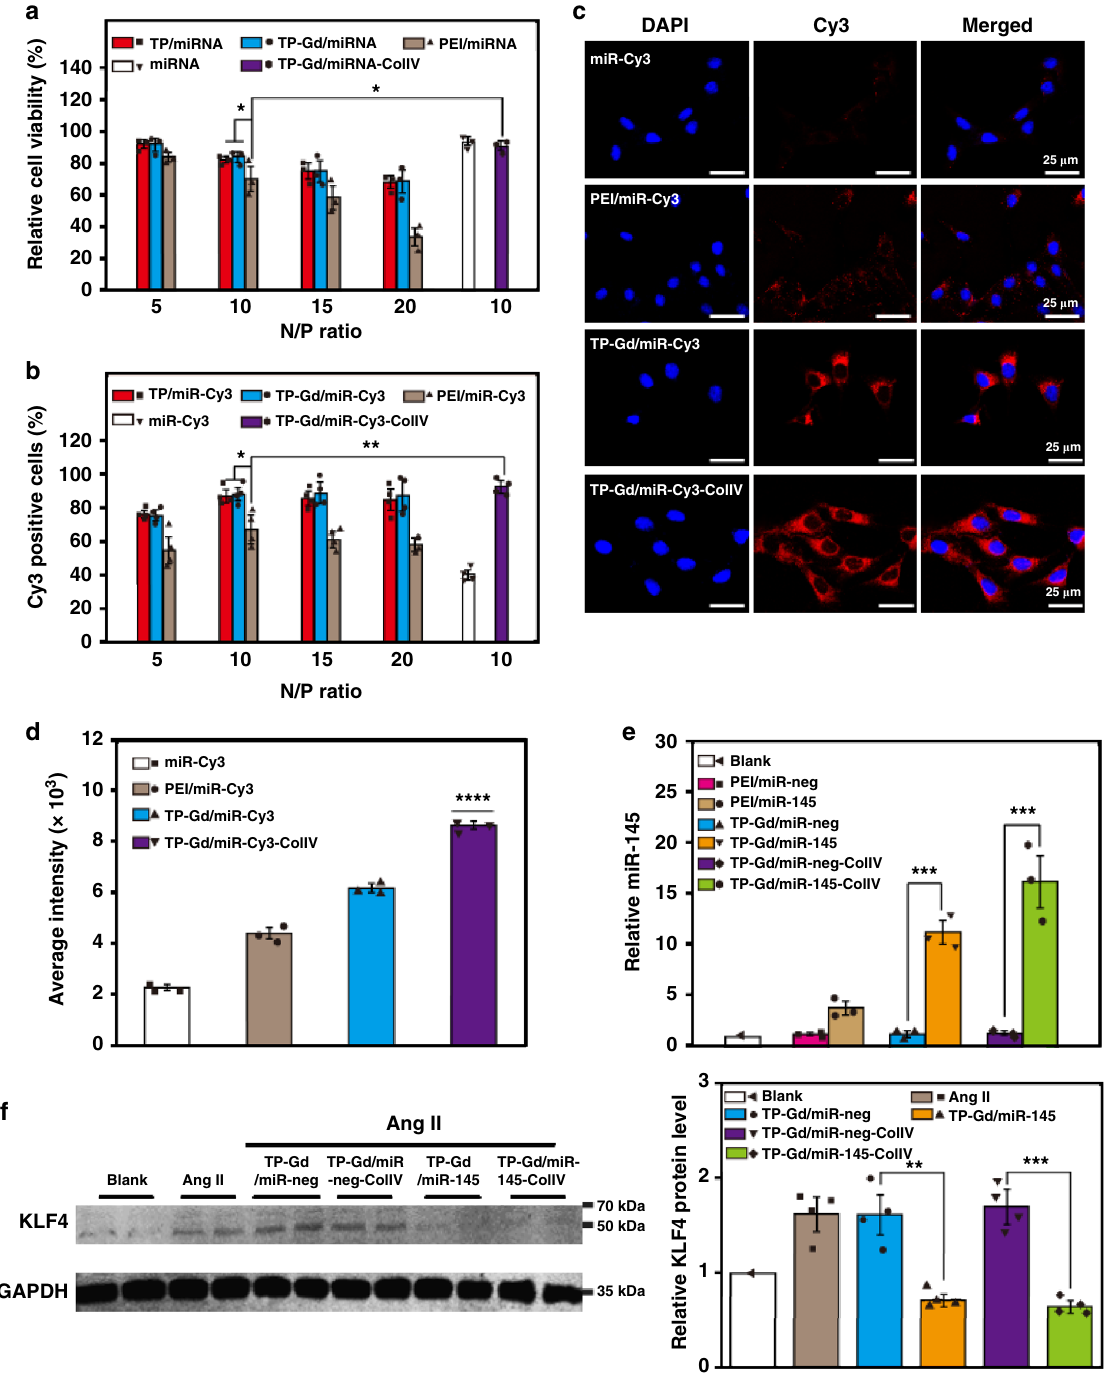
Fig. 3 a Cytotoxicity and b cellular uptake of polycation/miRNA complexes at different N/P ratios in smooth mouse cells (SMCs). Cellular internalization of polycation/miRNA complexes at the N/P ratio of 10 in SMCs: c Confocal fl uorescence images, d average intensity measured by MD, e relative expression levels of miR-145 and f related KLF4 protein expressions determined by western blot. (* p < 0.05, ** p < 0.01, *** p < 0.001 and **** p < 0.0001, see “ Statistical analysis ” in “ Methods ” ; n ≥ 3 independent experiments; error bars represent standard deviation; Source data of a , b , d – f are provided as a Source Data fi